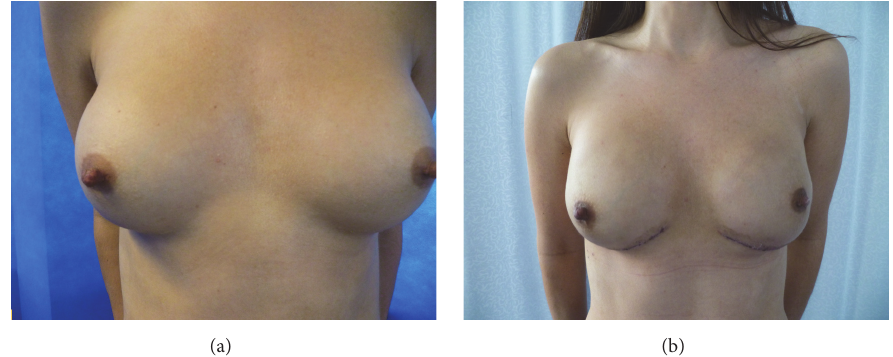
Figure 2: Young lady with small native breasts with bilateral submuscular cosmetic implants in situ, BRCA carrier (Case 1). (a) Pre- op photograph showing lateral displacement of right breast with wide cleavage. (b) Post-op photograph after bilateral nipple sparing mastectomies and one-stage implant reconstruction with modified lower pole dermal